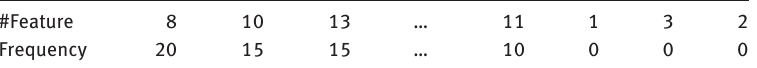
Table 5. Frequency of Selected Features in 20 Pareto Solutions Obtained for the Australian Data